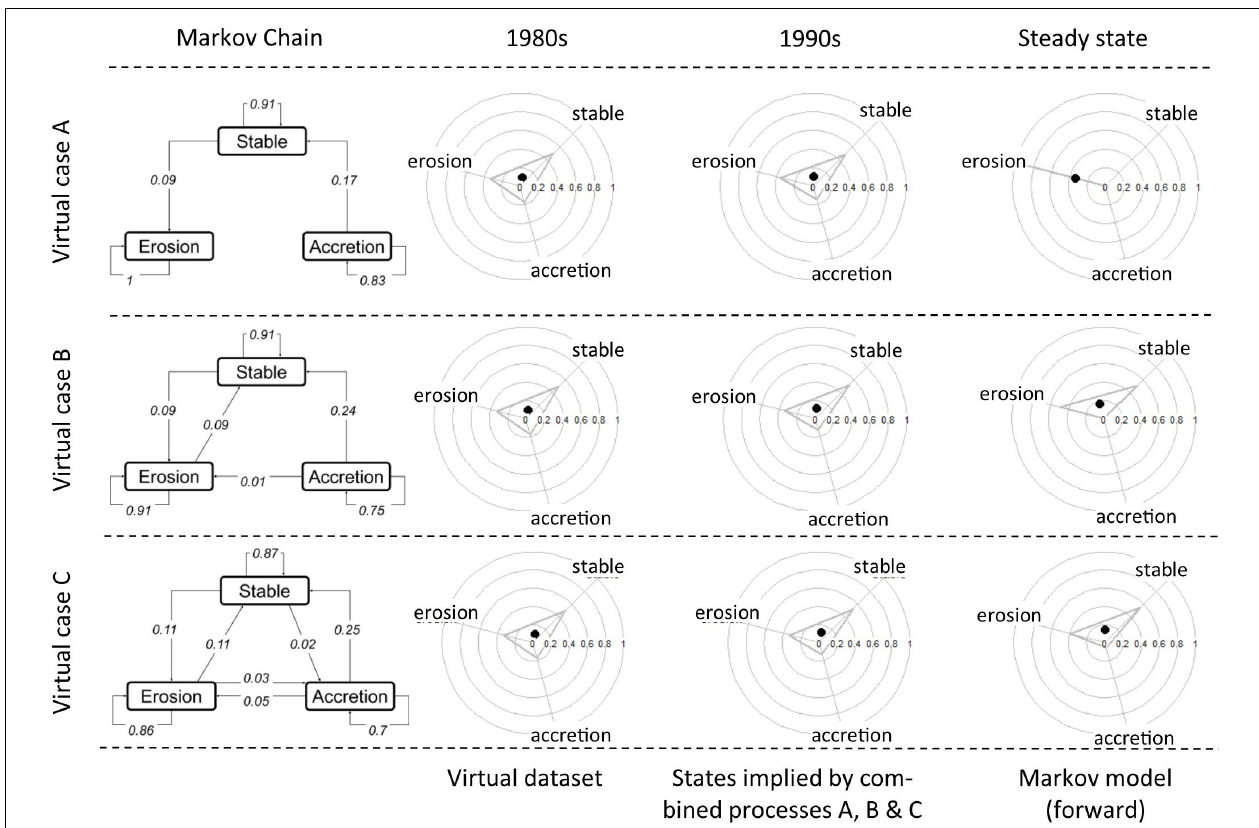
FIGURE 5 | Illustrative virtual cases, displaying the graph associated with the Markov chain, whose parameters have been learned from the virtual dataset. The radial plots indicate the proportion of eroding, accreting and stable segments. The 1980s state assumes that 50% of coastal segments are stable, 33% are eroding and 17% accreting. The virtual case A considers sea-level rise only, as in eqn. 3. The virtual case B assumes that the effects of sea-level rise are superimposed with a process converting 10% of accreting and 10% of eroding segments to stability. The virtual case C superimposes additional random transitions with magnitudes lower than 5%. The dark plot in the radial plots indicates the barycenter (center of mass) of each triangle. The displacement of the triangle from the initial state (1980s) to the 1990s or steady states allows identification of the shoreline evolution trends underpinned by the graph (3 states, 9 parameters, among which 6 are independent